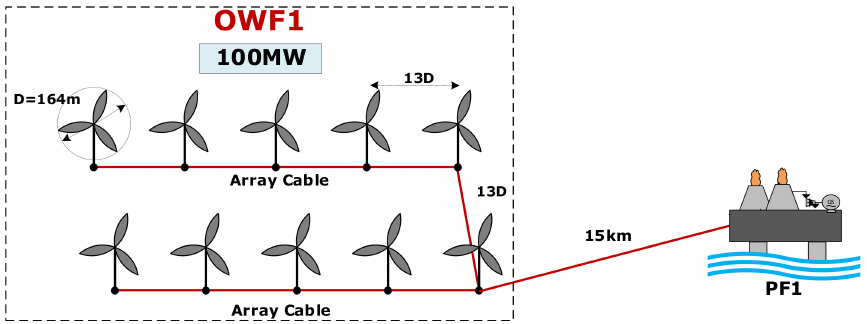
Figure 2. Case-1 OWF